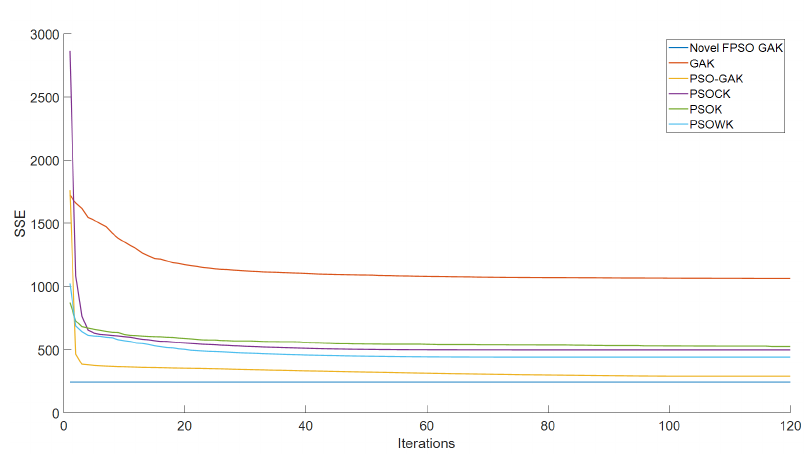
Figure 5. The SSE convergence curve for the searching optimal initial clustering centers stage of taxi GPS dataset from Beijing (China).